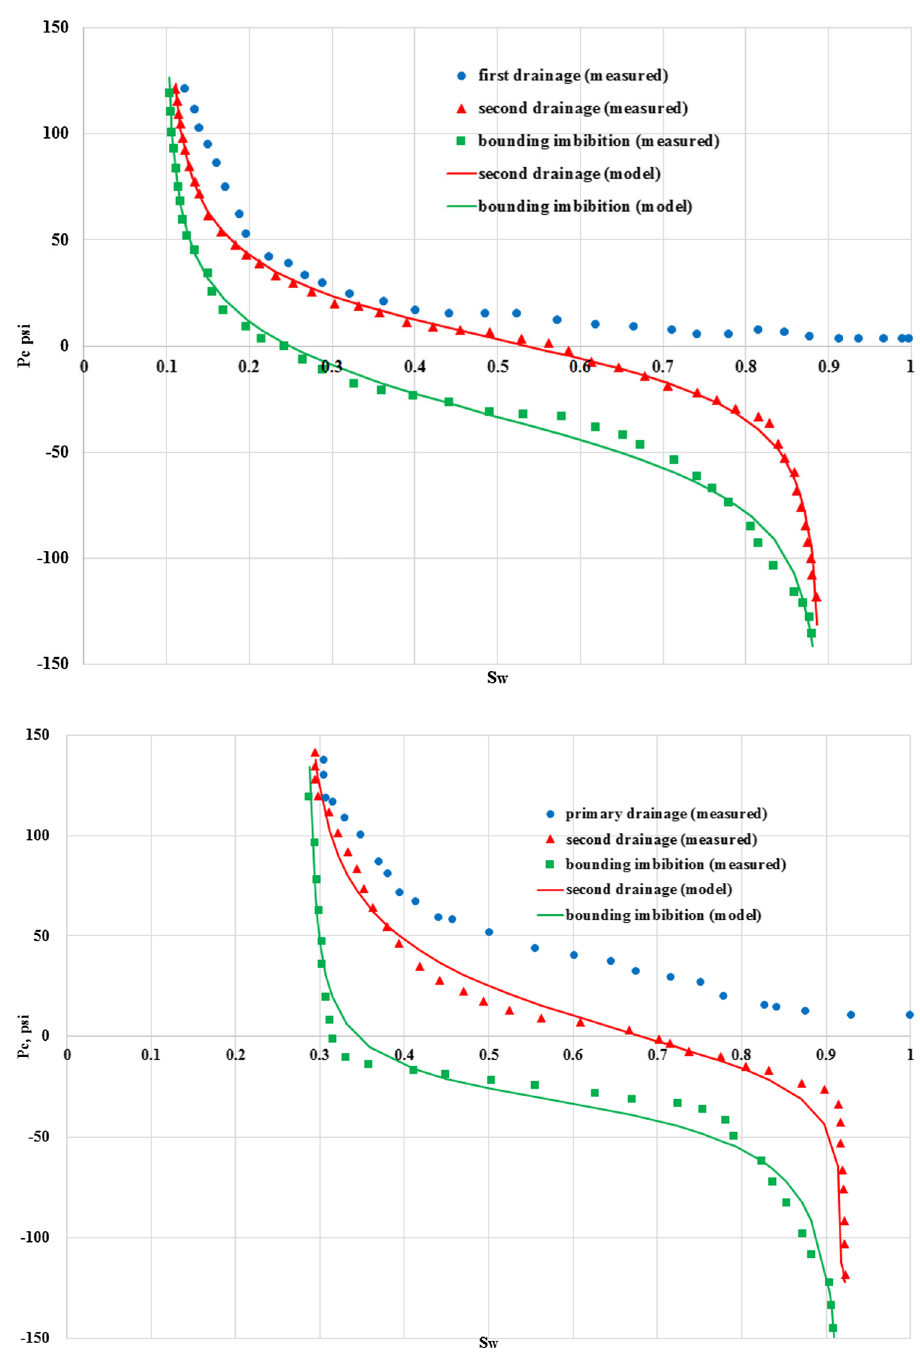
Fig. 5 Curve fitting of